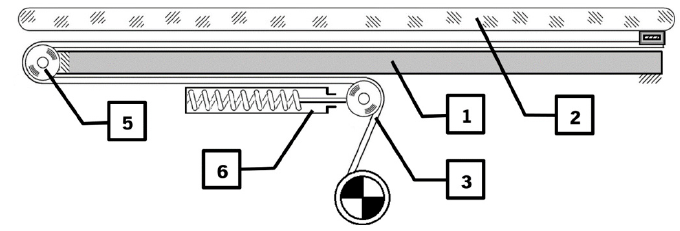
Figure 4. Track layout.